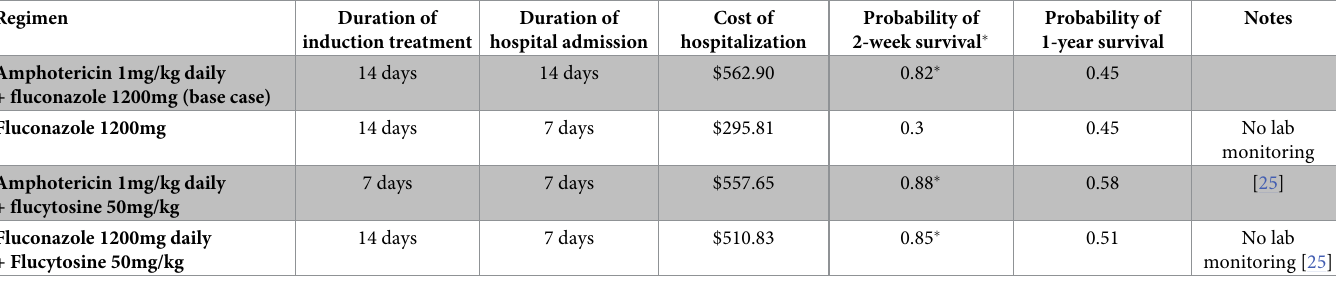
Table 3. Hospital costs and survival with alternative drug